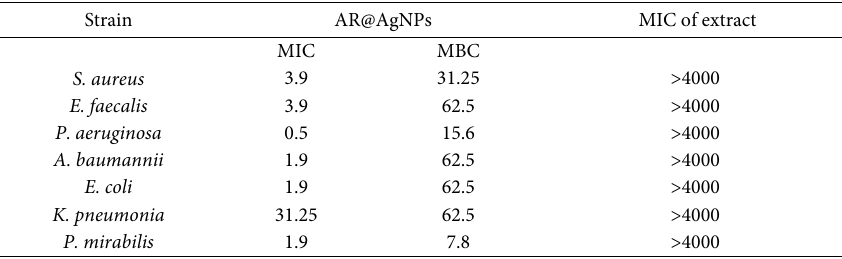
Table 3. Antibacterial activities of AR@AgNPs against clinical isolated bacteria